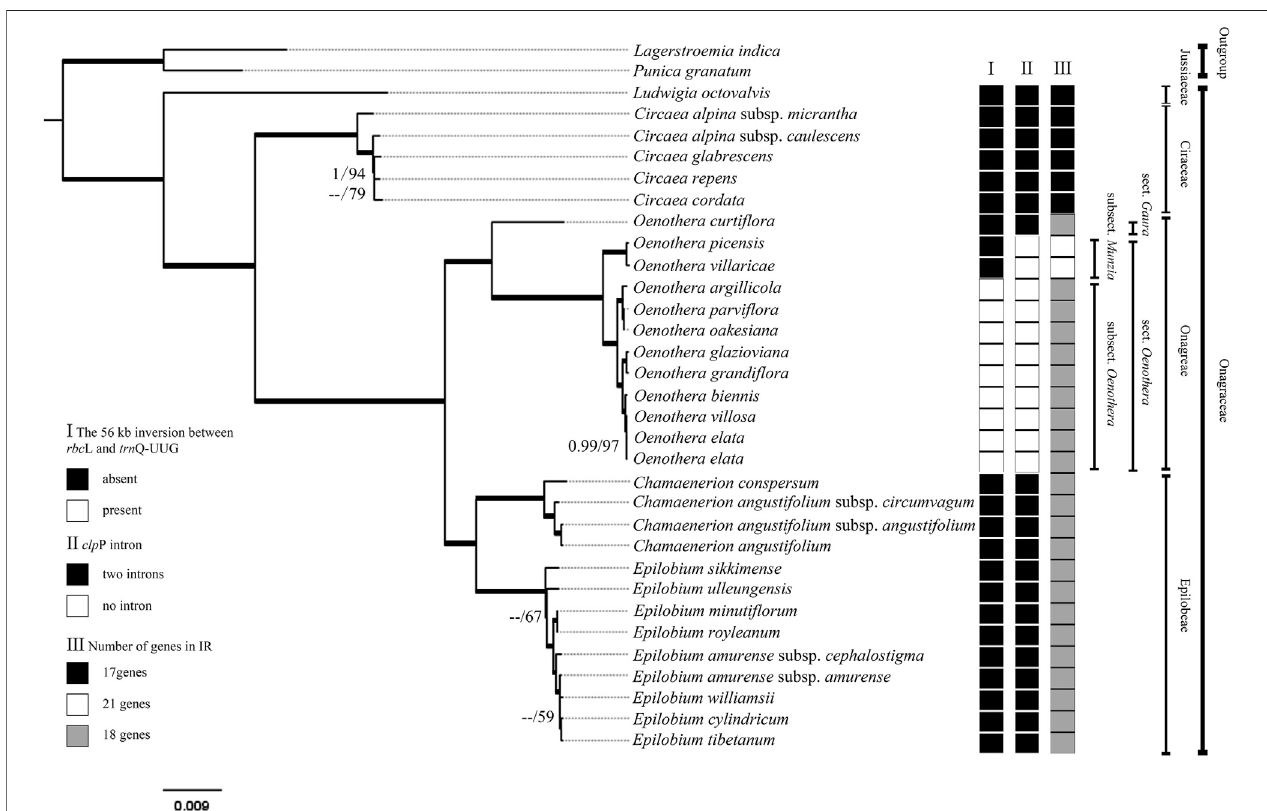
FIGURE 6 | Bayesian consensus tree of Onagraceae species inferred from complete chloroplast genome sequences. Maximum likelihood (ML) bootstrap values/ Posterior Probability (PP) values are shown at each node. Internal branches that are fully supported by both analyses (with 100 ML bootstrap values and 1 PP values) were thickened. ML bootstrap values < 50 and PP values < 0.95 are shown as --.